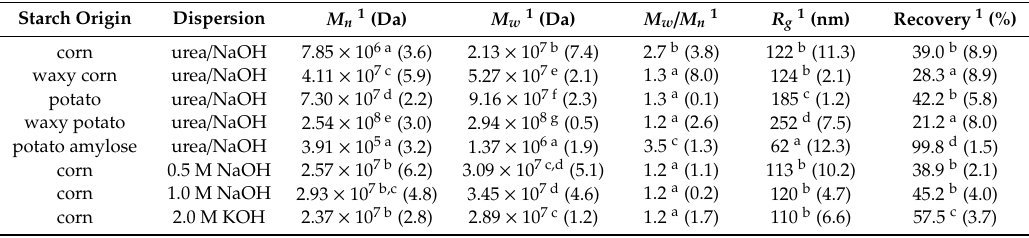
Table 2. SEC results of starch samples dispersed in aqueous solution of urea (2.3 M) / NaOH (1 M) at 0 ◦ C for 24 h and NaOH or KOH at 65 ◦ C for 1h; the values of the coe ffi cient of variation (%) were given in